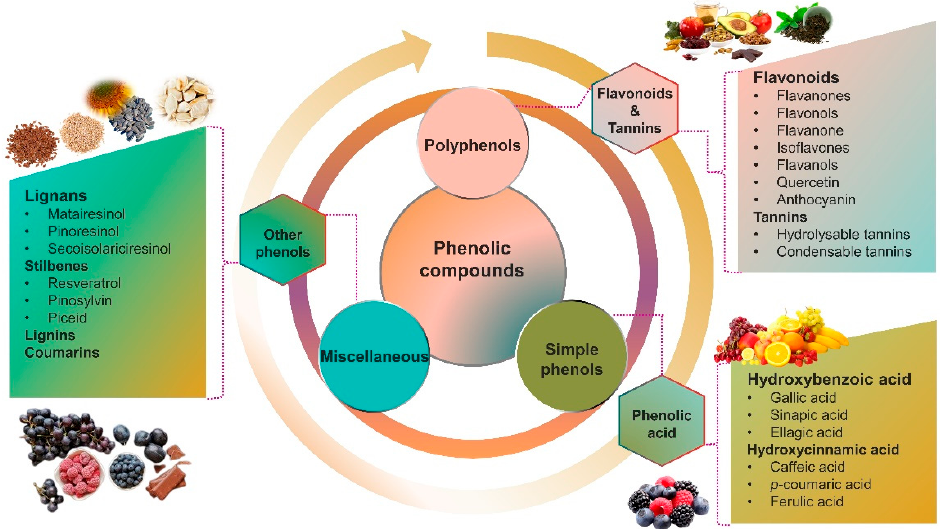
Figure 1. Schematic illustrating numerous naturally occurring phenolic